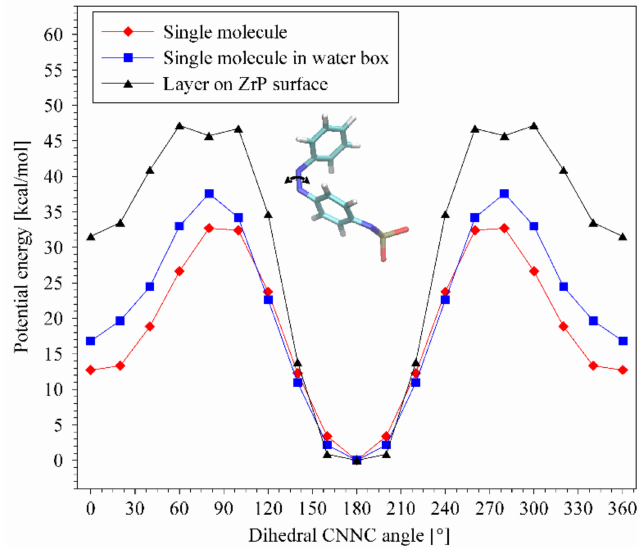
Figure 12. Potential energy of C–N = N–C rotation of single pAz molecule, single pAz molecule in a water box, and a layer of pAz molecules on the ZrP